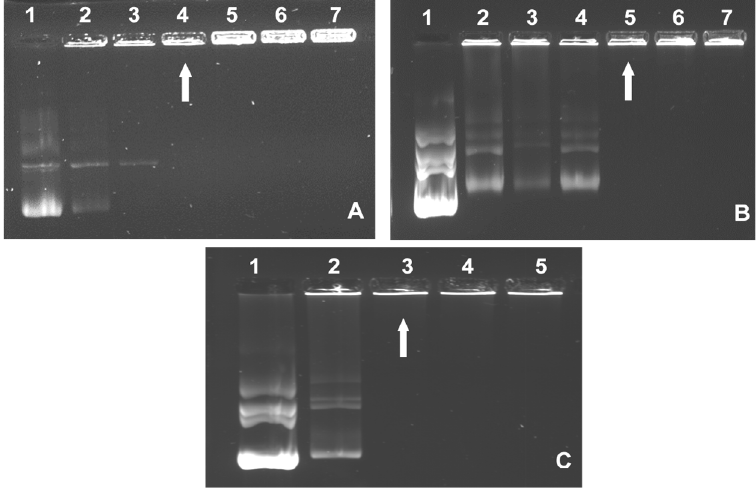
Figure 4. Band shift assays of nanocomplexes: ( A ) Au-CS (lanes 2–7: 0.25, 0.38, 0.5, 0.63, 0.75 and 0.88 µ g); ( B ) Au-CS-His (lanes 2–7: 0.5, 0.6, 0.7, 0.8, 0.9 and 1.0 µ g) and ( C ) Au-CS-FA-Hist (lanes 2–5: 1.13, 1.25, 1.38 and 1.5 µ g). Lane 1: Control (0.25 µ g pDNA). ( A , B ) (Lanes 2–7) and ( C ) (Lanes 2–